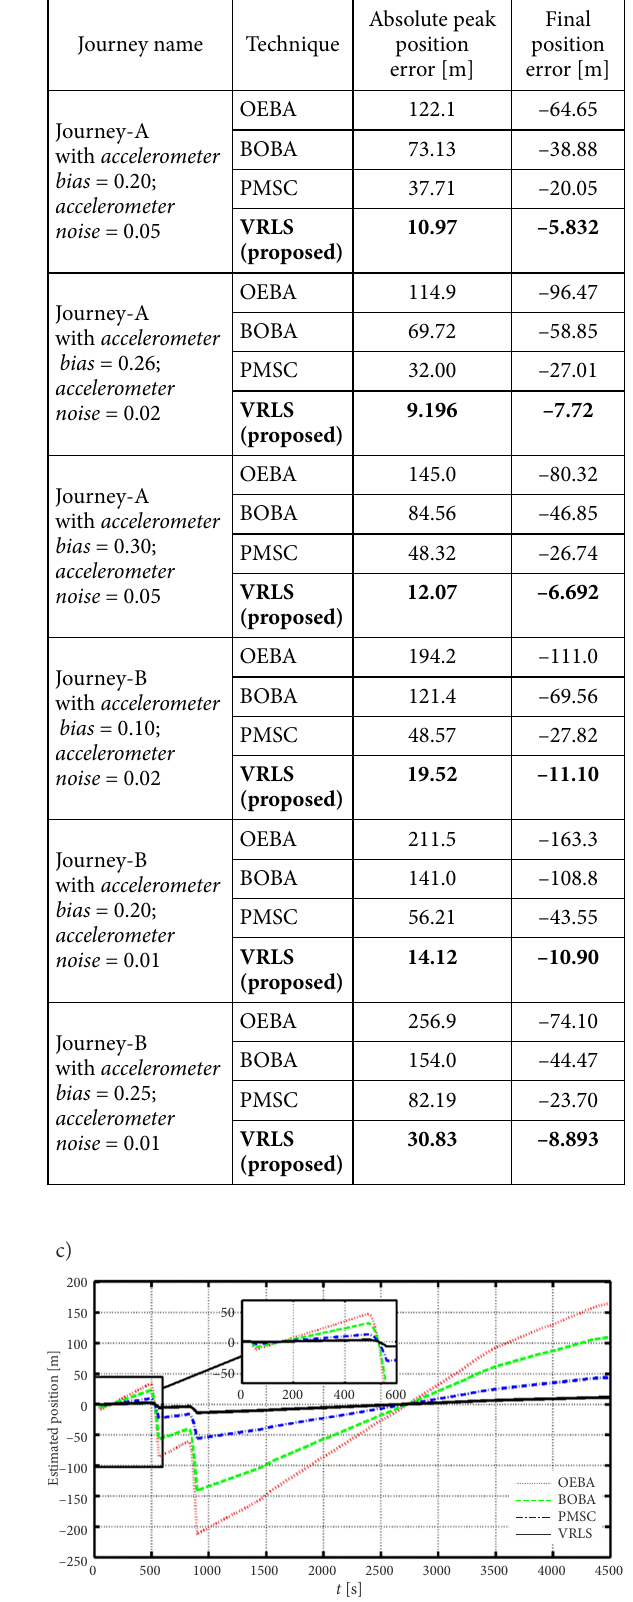
Table 3. Comparative performance of the fusion-filtering techniques for velocity error estimation